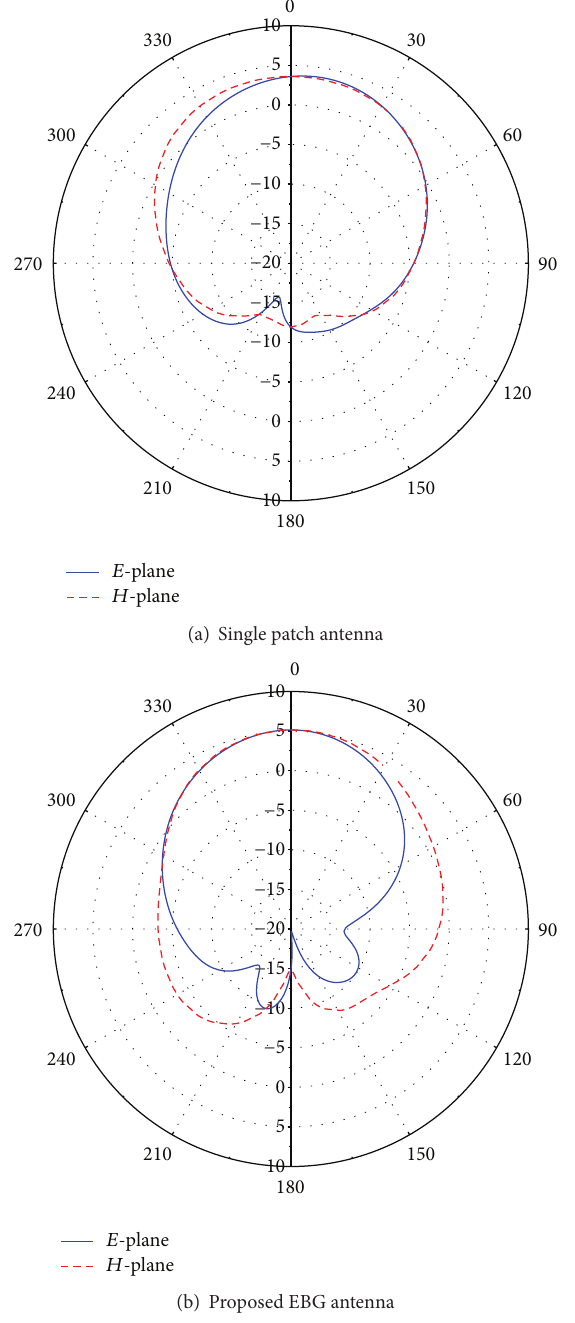
Figure 13: Radiation pattern of single patch antenna and proposed EBG antenna at 5.06 GHz.